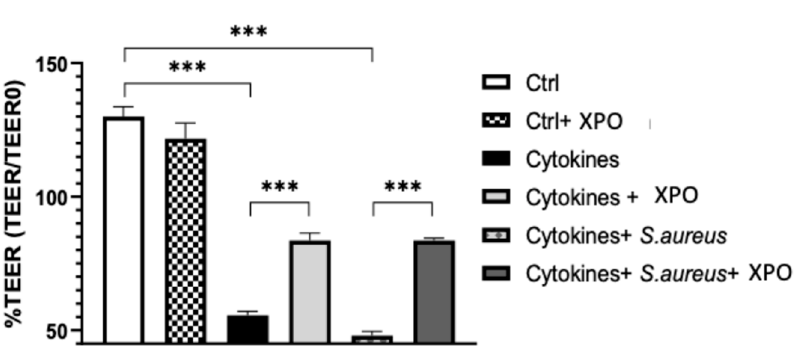
Figure 1. TEER measurement. The barrier-protective properties of XPO on keratinocytes were assessed through the TEER test, observing that HaCaT stimulation with cytokines mix and cytokines mix + S. aureus significantly reduced TEER measurement compared to control cells; interestingly, XPO treatment prevented TEER decrease, highlighting the role of XPO in supporting epithelial barrier integrity in keratinocytes. Values are indicated as the mean ± SEM. *** p < 0.001 .